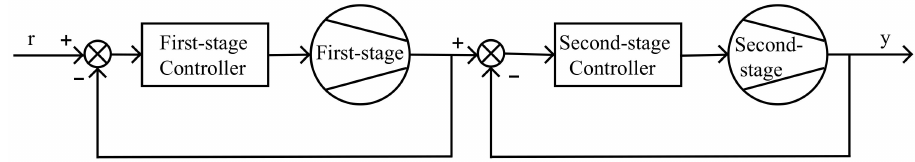
Figure 1. The stepless flow control system for a two-stage